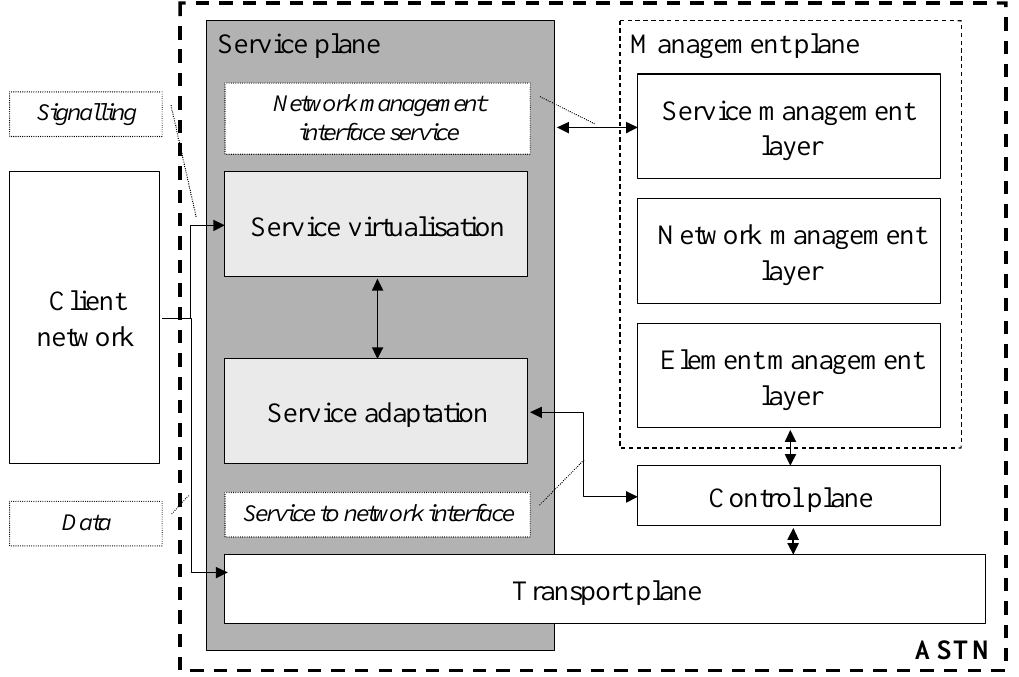
Figure 1. Service Oriented Optical Network (SOON)‟s service plane building blocks and interfaces. Adapted from